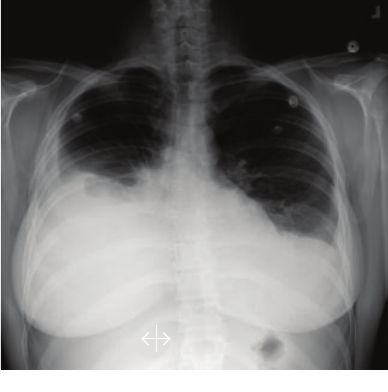
an antagonist protocol with daily injections of 300 IU of recombinant follicle-stimulating hormone (rFSH) and 150 IU of hMG. 250 µ g of Ganirelix Acetate injection was started on day 9 and continued for 4 days. 10,000 units of hCG intramuscularly were given when two lead